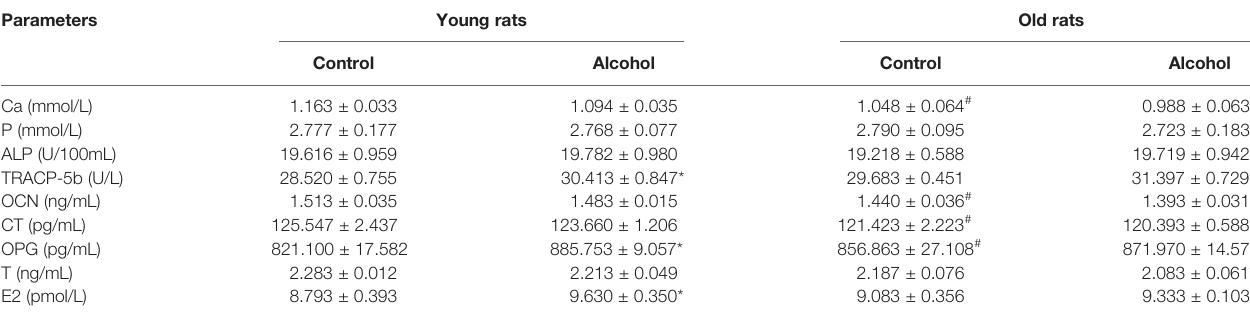
TABLE 2 | Osteopenia-related serum biochemical parameters in young and old rats after long-term drinking. Parameters Young rats Old